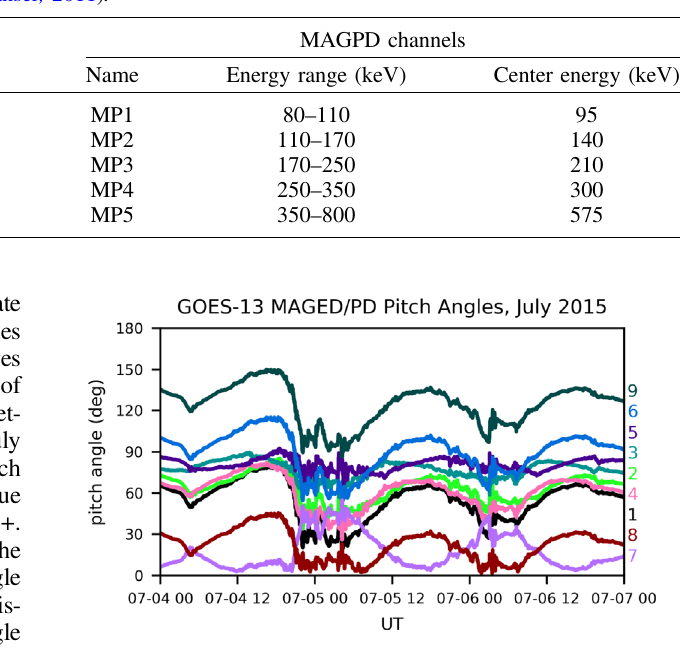
Fig. 1. Three days of GOES-13 MAGED and MAGPD telescope pitch angles (4 – 6 July 2015), showing examples of disturbed and quiet periods. The pitch angles are at the centers of the telescope FOVs. The telescope numbers are identi fi ed at the right, ordered by the pitch angle values at 00 UT on 7 July 2015, using colors corresponding to those of the